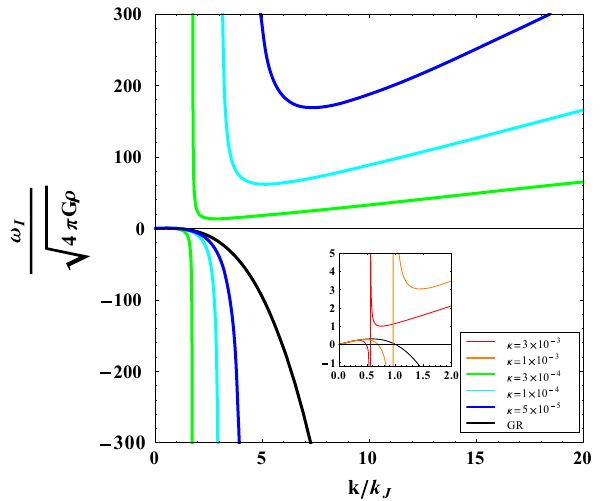
Fig. 3 ThegrowthrateoftheJeansinstabilityversus k / k J fordifferent values of the EiBI parameter. Here the dispersion relation is illustrated for the cases corresponding to κ > 0